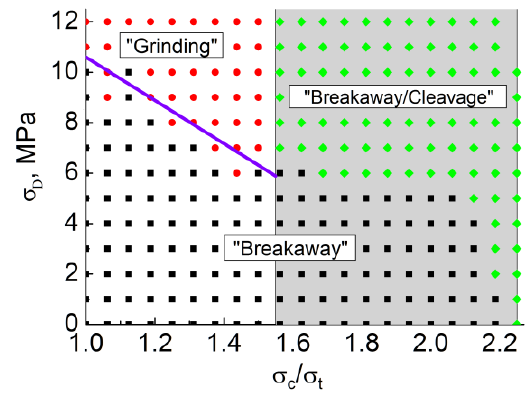
Fig. 6. The cloud of points corresponding to different regimes of wear under the variation of the specific adhesion stress  D and the parameter a of Drucker-Prager fracture